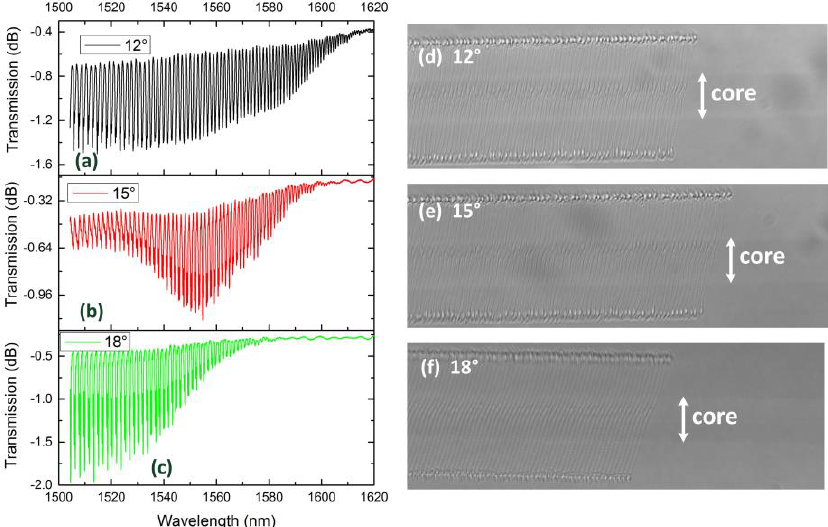
Figure 5. Transmission spectra of ( a ) 12°TFBG, ( b ) 15°TFBG and ( c ) 18°TFBG, and microscopy image (100×) of ( d ) 12°TFBG, ( e ) 15°TFBG and ( f ) 18°TFBG.